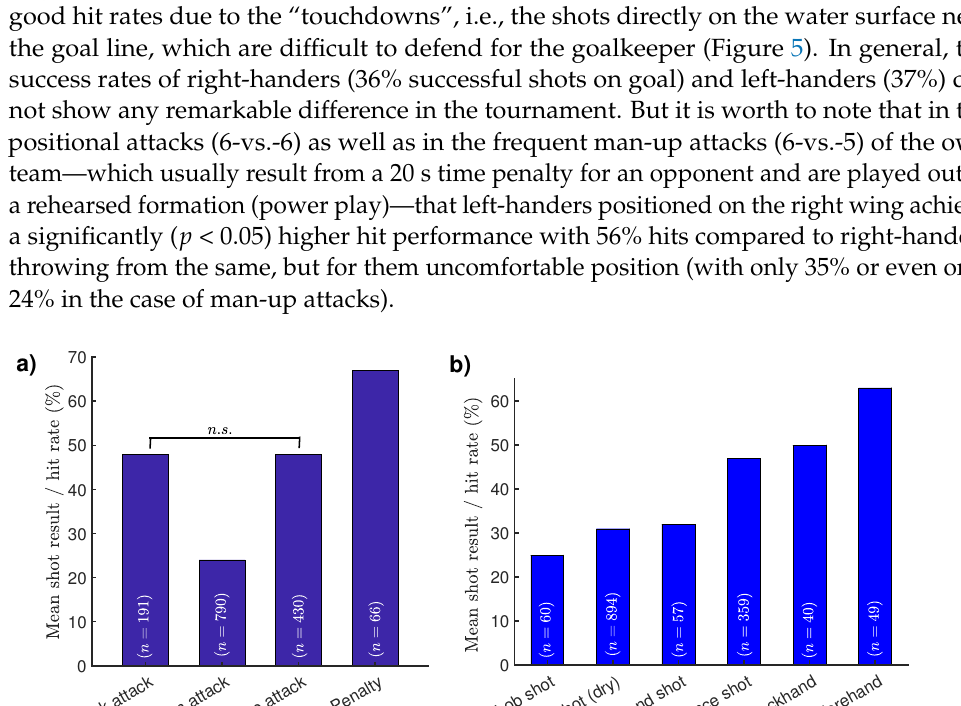
rarer backhand shot and lob shot, which are typically used in water polo from the outside positions and the center player positioned near the 2 m offside line in the center in front of the goal, respectively, are far less successful (Figure